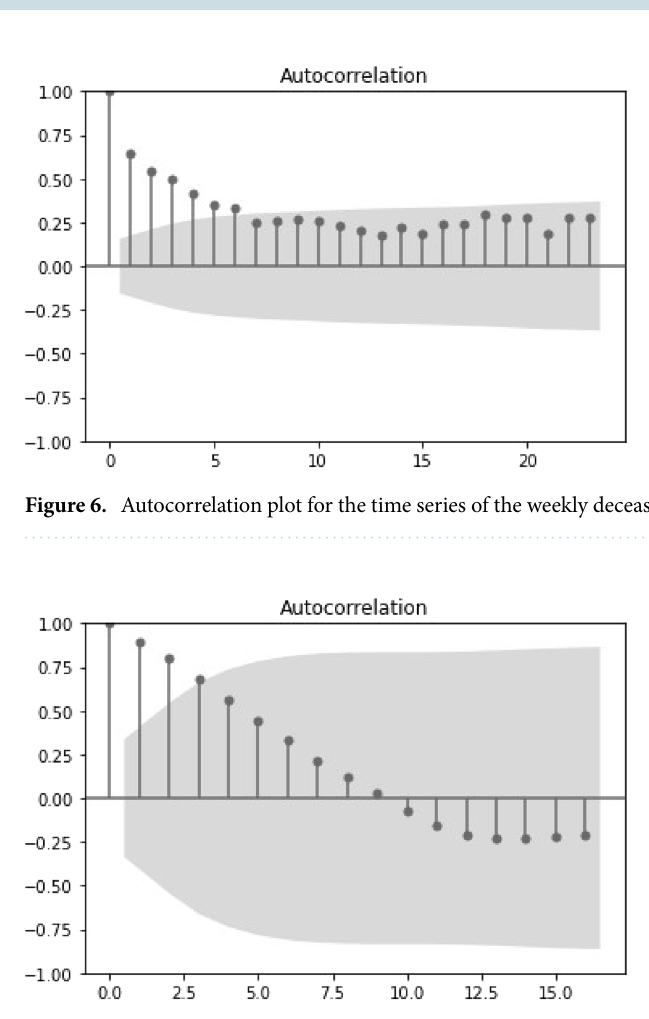
Figure 7. Autocorrelation plot for the time series of the annual living donors.